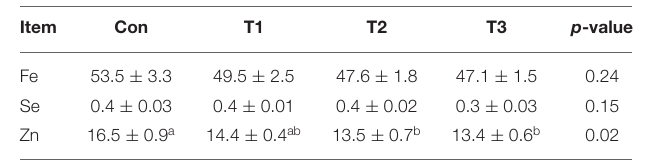
TABLE 4 | Effects of dietary supplementation with Elephantopus scaber on Fe, Se, and Zn contents in breast muscle (mg/kg